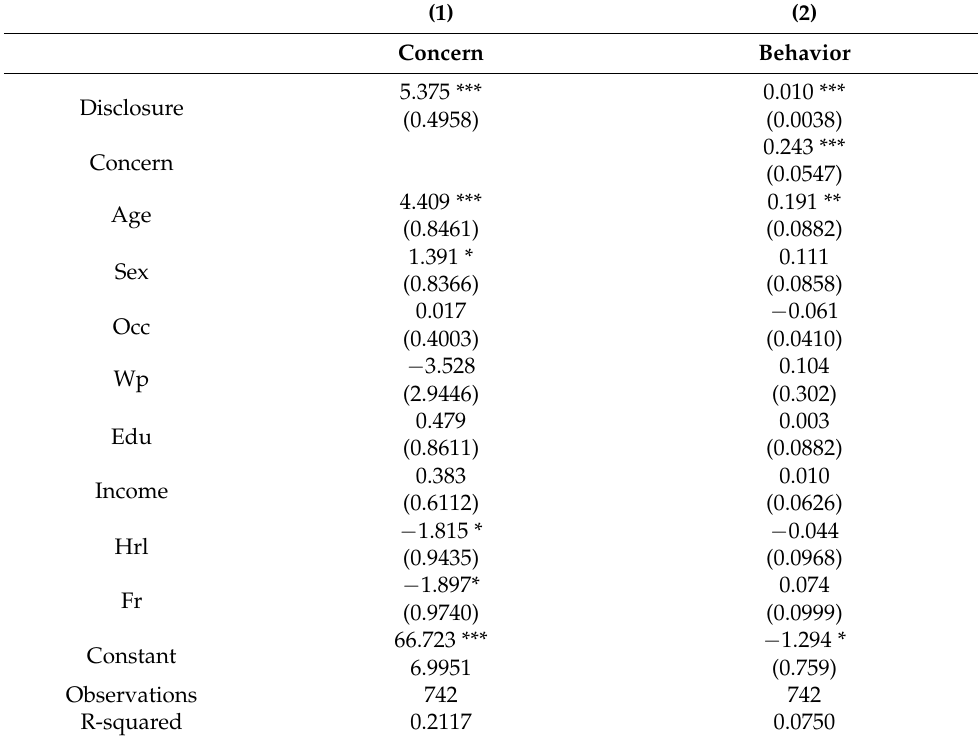
Table 7. Mediating effects affect test results.